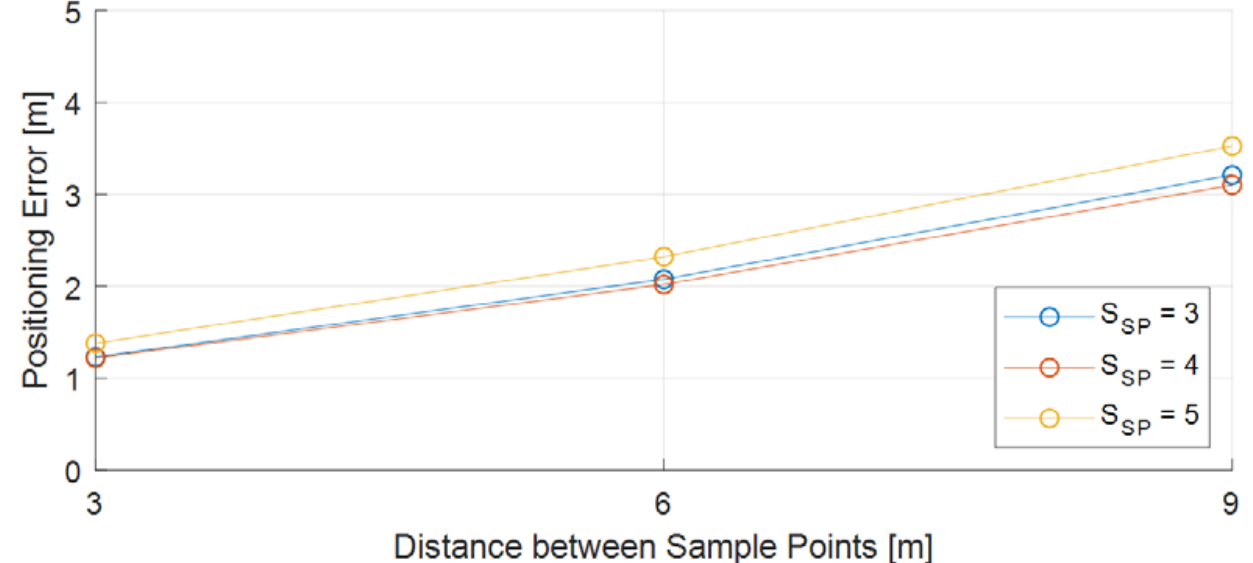
Figure 3. Positioning error according to number of selected SPs.